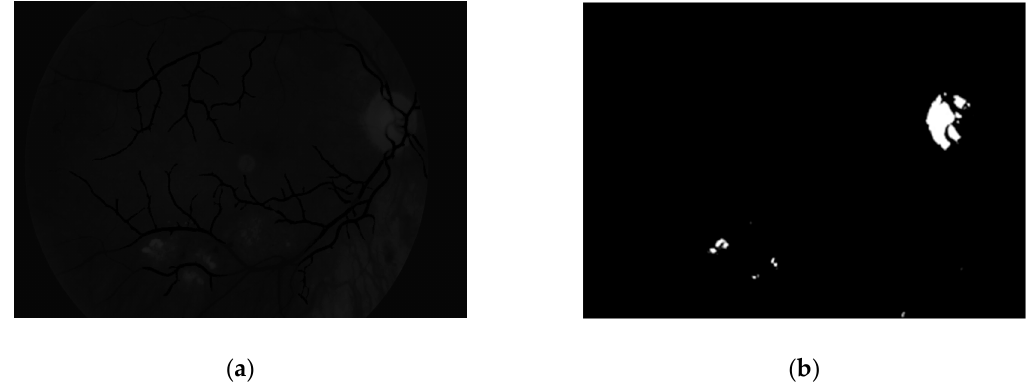
Figure 15. Image ( a ) after vascular pattern removal and ( b ) after binarization.